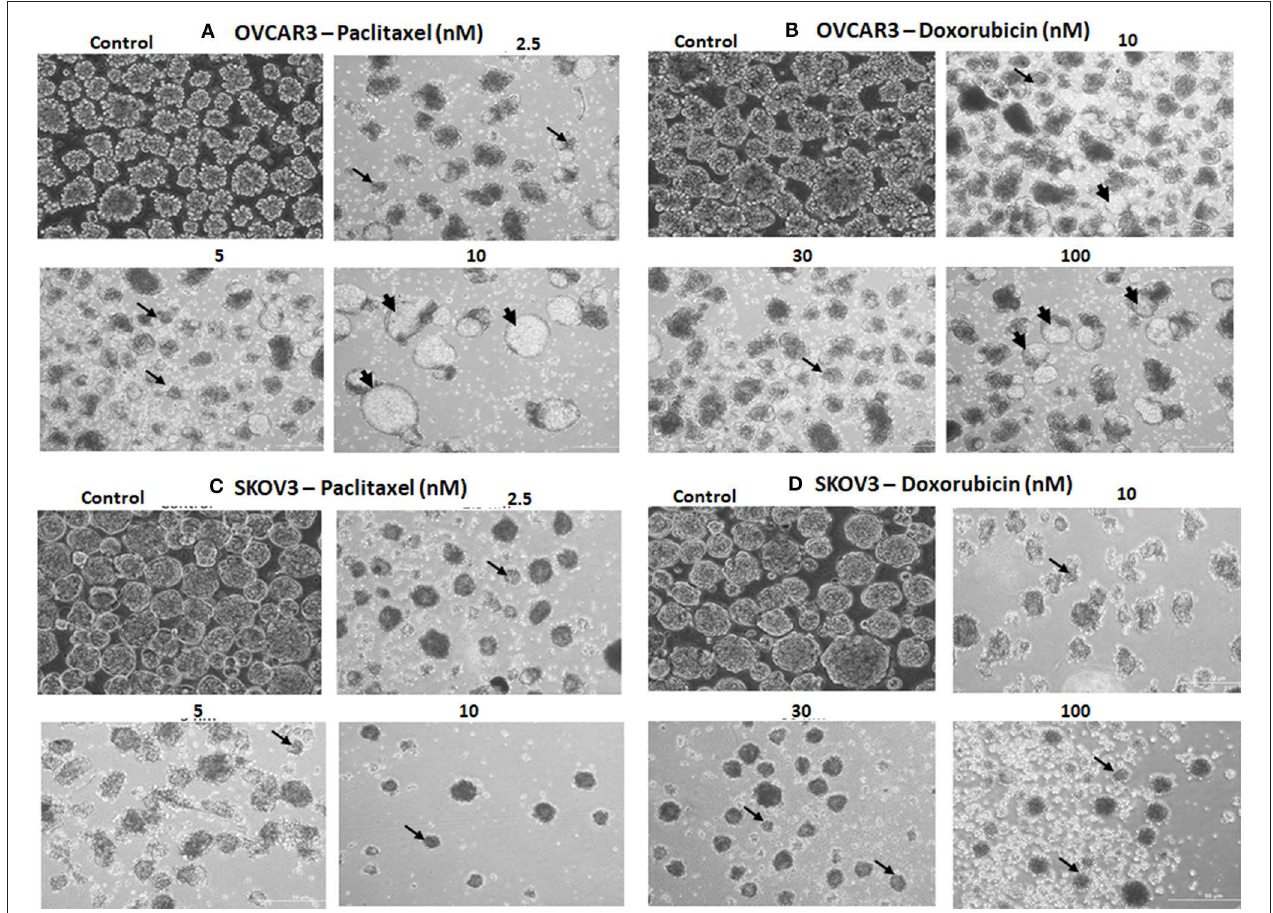
FIGURE 9 | Representative phase contrast images of the tumor spheres (TS) of (A) OVCAR3 treated with paclitaxel; (B) TS of OVCAR3 treated with doxorubicin; (C) TS of SKOV3 treated with paclitaxel and (D) TS of SKOV3 treated with doxorubicin. Decrease in TS size, numbers and cell death/degeneration were more evident following treatment with paclitaxel (2.5, 5, 10nM) than with doxorubicin (10, 30, 100nM) for 48h. Thin black arrows indicate the decrease in size of TS, while thick black arrow heads indicate the cystic degenerative changes noted with OVCAR3 tumor